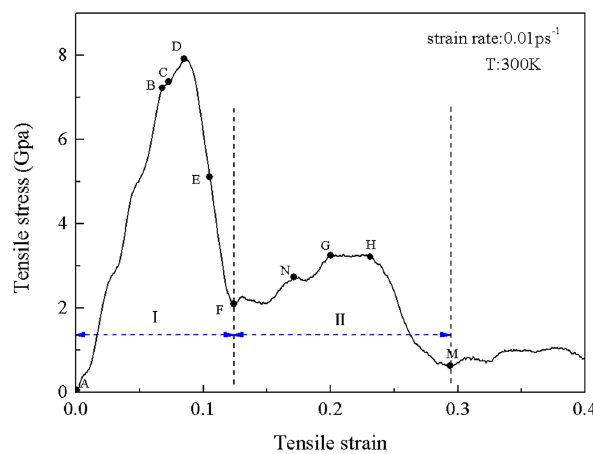
Figure 2: Stress – strain curve of Cu/Al 2 Cu/Al interface system under vertical interface tensile